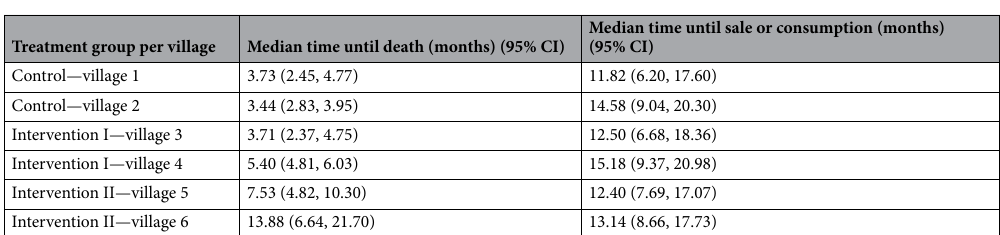
Table 2. Estimated median time until death of ducks and until consumption or sale of ducks by treatment groups.